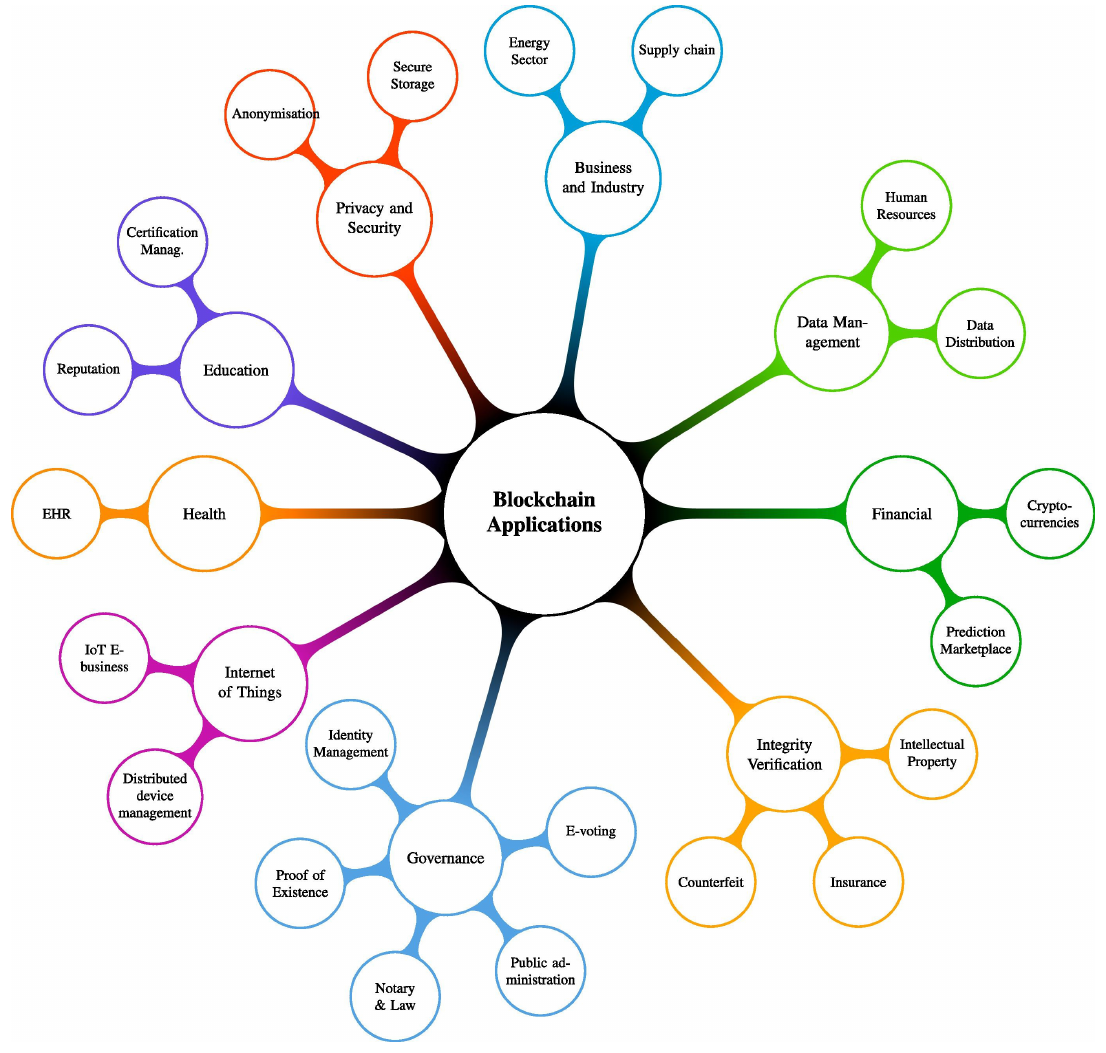
Figure 4. Blockchain technology (BCT) Applications Taxonomy